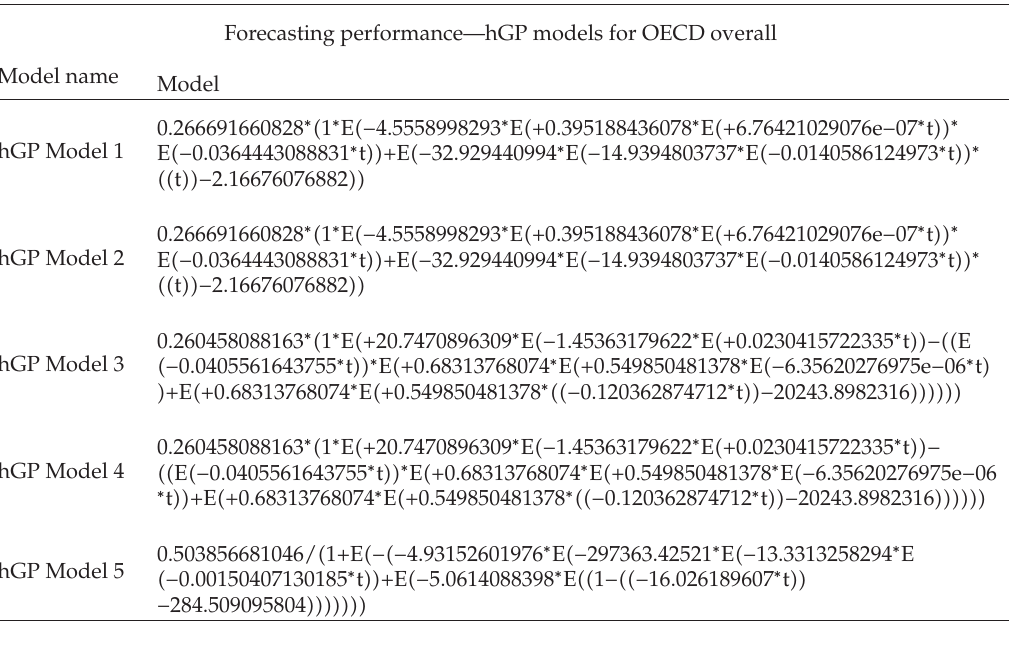
Table 29: Representation of the first five produced hGP models in forecasting (cid:2) OECD overall (cid:3) . Forecasting performance—hGP models for OECD overall